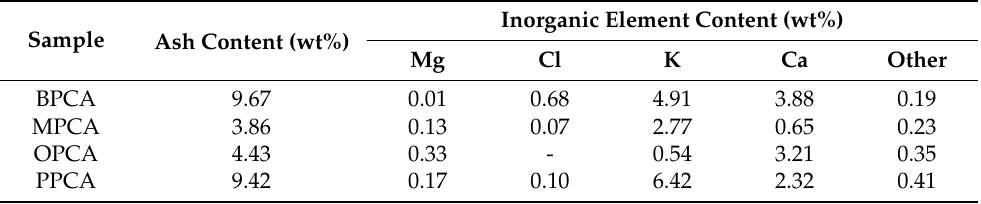
Table 3. Ash content and inorganic element content of CAs prepared from different waste biomasses.